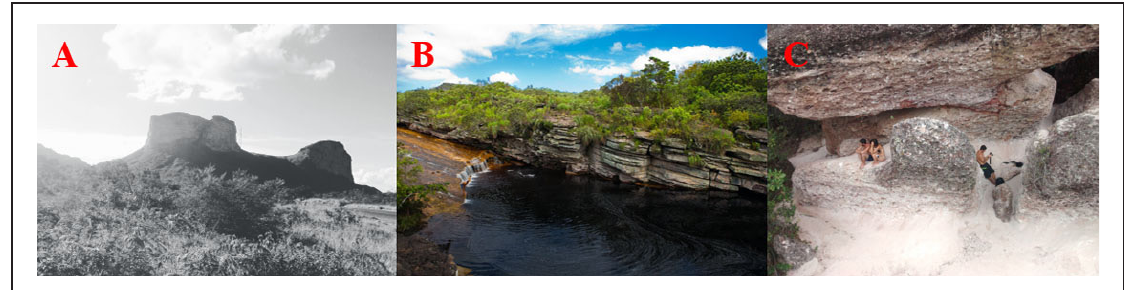
FIGURE 4. Most visited attractions. A – Morro do Pai Inácio, B – Mucugezinho River balneario, C – Serrano. Photos by the author (A and C) and Açony Santos